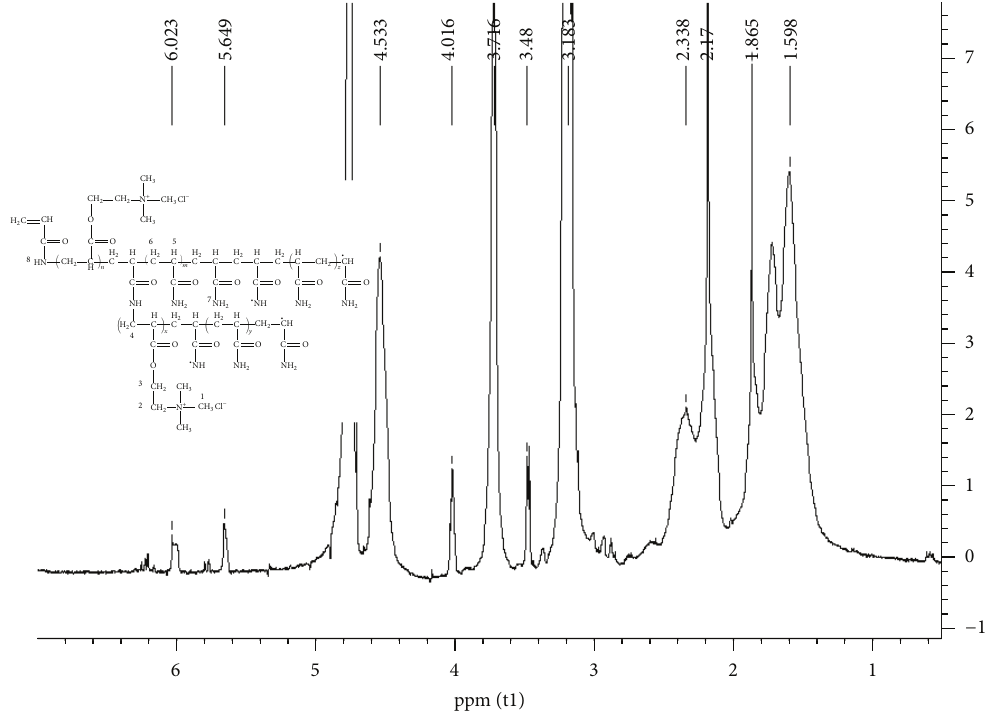
Figure 4: 1H NMR of branched cationic polyacrylamide.